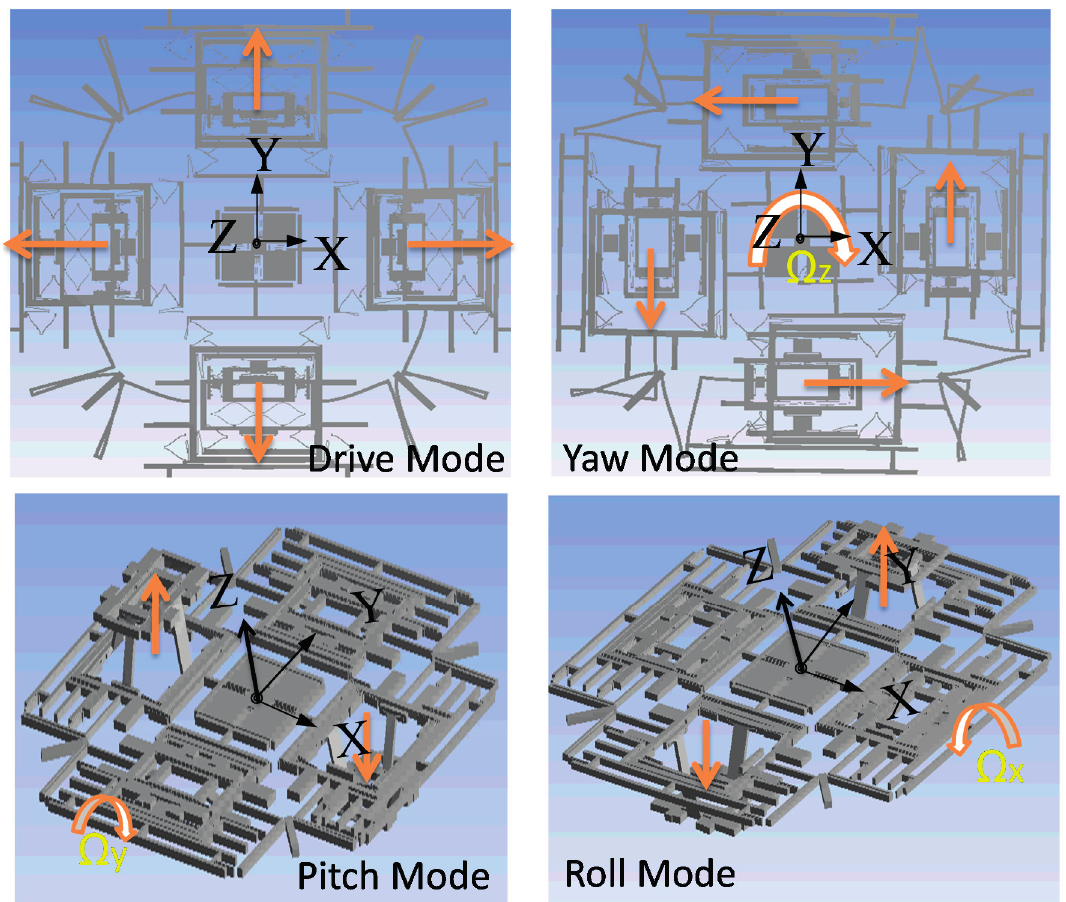
Figure 2. Schematic diagrams for drive mode, yaw mode and pitch/roll